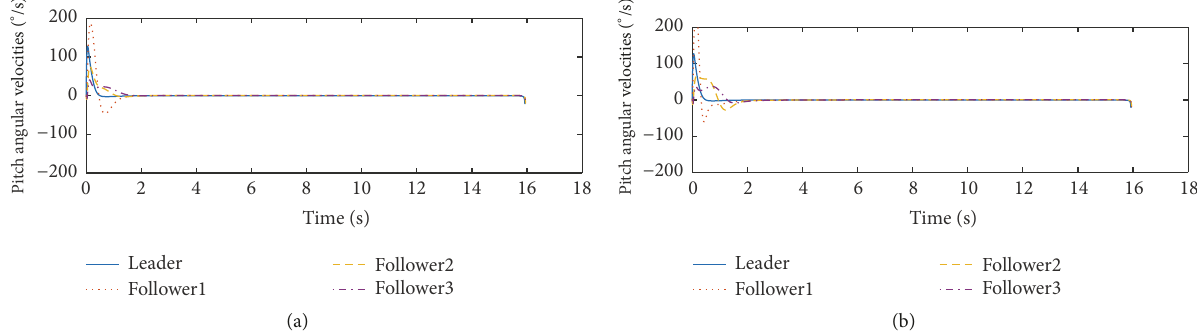
Figure 10: Pitch angular velocities curve in the global and local communication topologies: (a) pitch angular velocities curve in the global communication topology; (b) pitch angular velocities curve in the local communication topology.